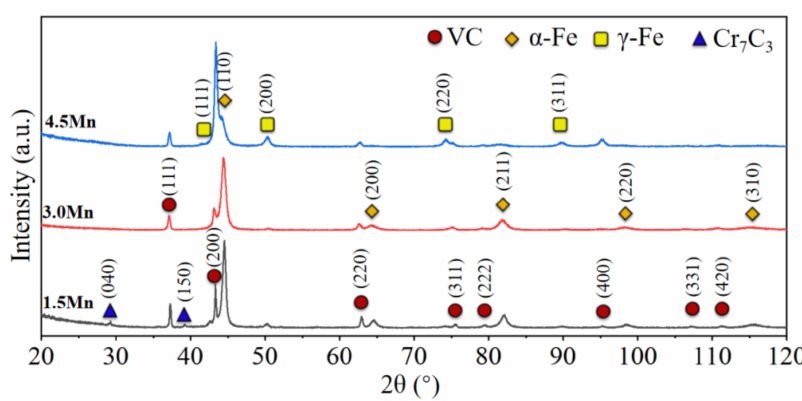
Figure 3. High-energy XRD patterns of three samples with different Mn content.